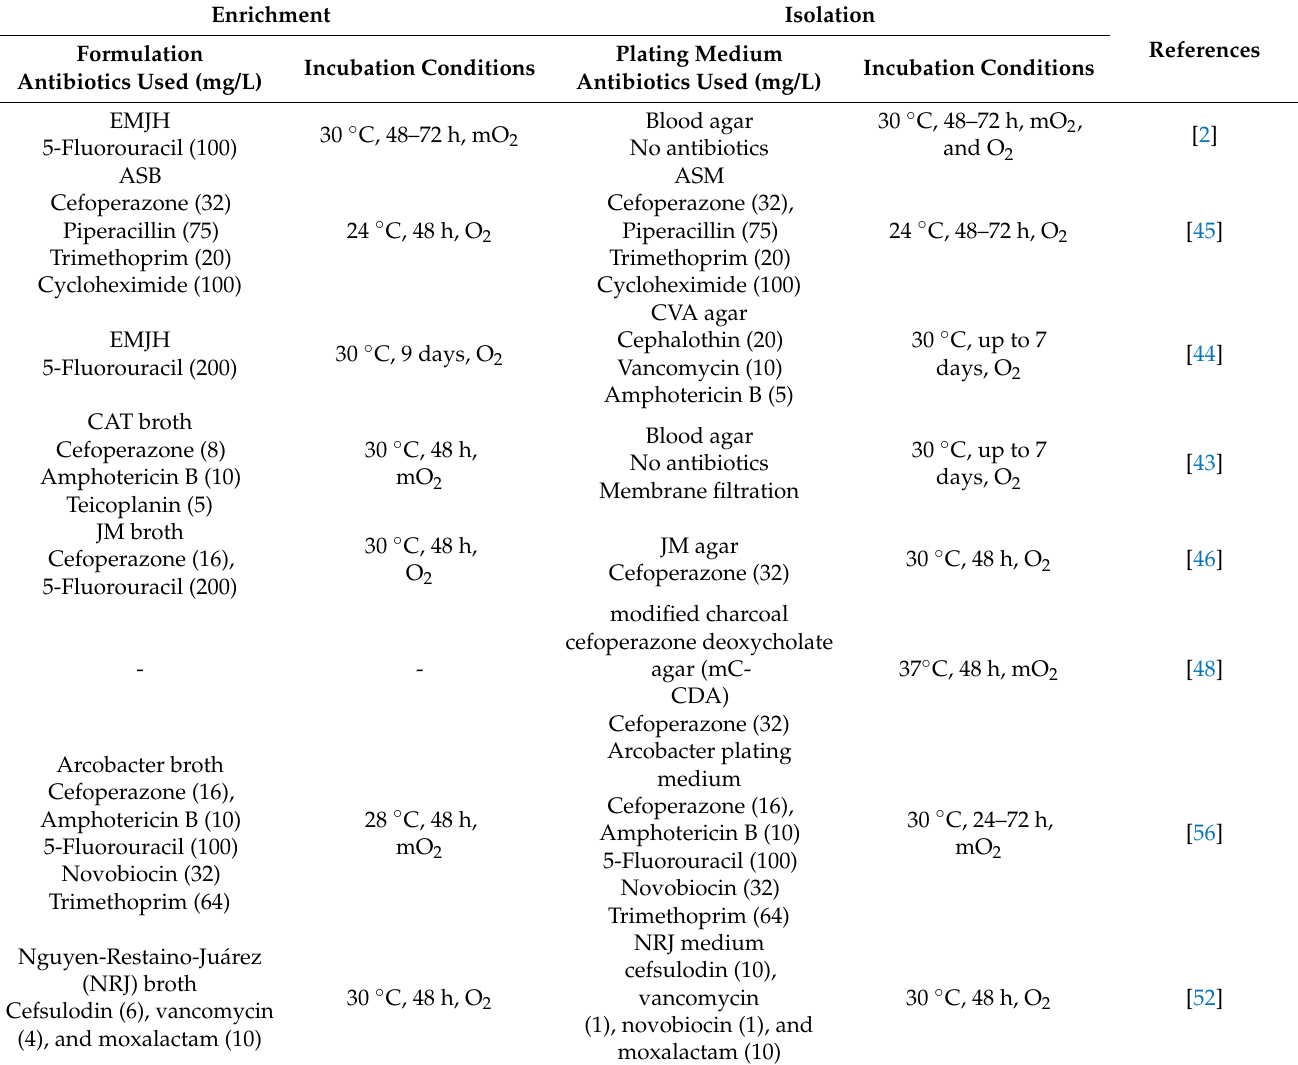
Table 3. Isolation and cultivation methods for Arcobacter